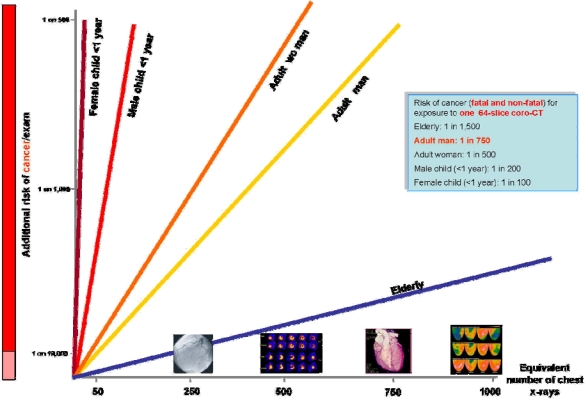
On the x axis, the doses of 4 common imaging examination are shown: coronary angiography (250 chest x-rays); myocardial perfusion scintigraphy (500 chest x-rays); 64-slice CT (750 chest x-rays); whole body CT- PET scan (1,250 chest x-rays). On y-axis risk for children (male and female), adults (men and women) and the elderly. Redrawn and modified from ref. [35].